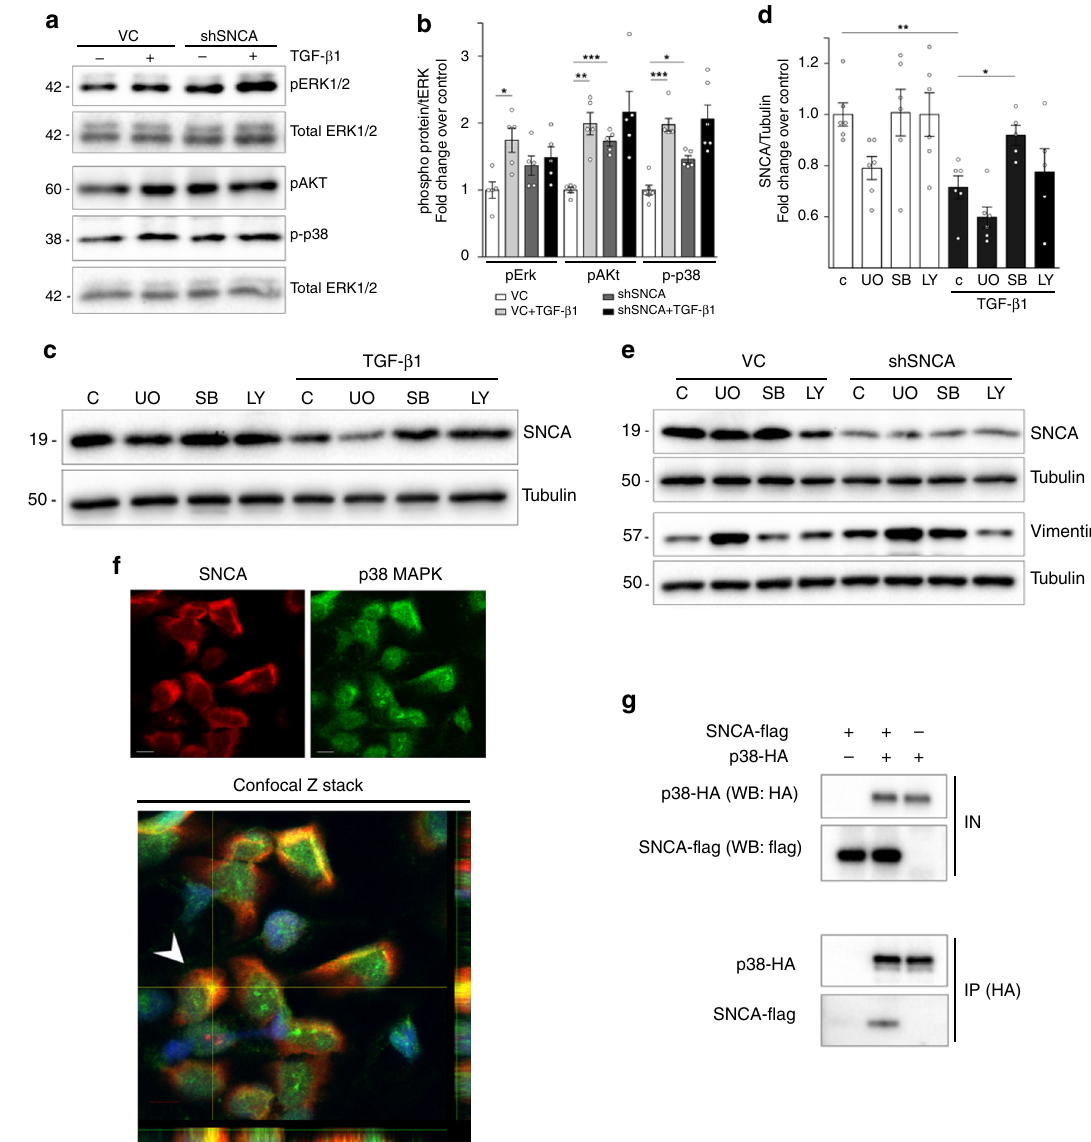
Fig. 3 SNCA modulates the activation of ERK1/2, Akt and p38 in vitro. a , b HK-2 cells were incubated separately with either serum-free medium or 2 ng/ ml TGF- β 1 for 60 min. Cell lysates were immunoblotted with antibodies against pERK1/2, p-p38, pAkt, total ERK1/2, and tubulin. Representative Western blots ( a ) and quantitative densitometric analysis ( b ) show levels of phosphorylated ERK1/2, p38, and Akt in HK-2. Data were normalized to total ERK1/2 ( b ) and presented as mean ± SEM of at least n = 3 independent experiments. c – e Effect of MAPK inhibitors (U0126 and SB203580) and PI3K-Akt inhibitor (LY294002) on TGF- β 1-induced decrease in SNCA expression ( c , d ), as well as SNCA knockdown-induced increase of vimentin in HK-2 ( e ). HK-2 were pretreated for 1 h with UO126, (UO; 10 µ M/L), SB203580 (SB; 20 µ M/L) or LY294002 (LY; 10 µ M/L), after which cells were incubated either with serum- free medium or TGF- β 1 (2 ng/ml) for 72 h. Cell lysates were immunoblotted with antibodies against SNCA ( c , e ), vimentin ( e ) and tubulin. Representative Western blots ( c , e ) and quantitative densitometric analysis ( d ) show levels of SNCA ( c , e ) and vimentin ( e ) in HK-2. Data were normalized to tubulin ( d ) and presented as mean ± SEM of at least n = 3 independent experiments. f The confocal Z stack shows colocalization of p38 with SNCA in the cytoplasm of HK-2. HK-2 cells were grown under normal conditions and were stained using anti-SNCA (red) and anti-p38 antibody (green). Nuclei were labeled by Hoechst (blue). The lower and right panels in the confocal Z stack show a vertical cross section (yellow lines) through the cells. Arrow, SNCA colocalized with p38 MAPK in the cytoplasm. Scale bar represents 10 µ m. g Immunoprecipitation of SNCA with p38. HEK293T cells were co-transfected with p38-HA and SNCA- fl ag. After crosslinking with DSP, p38 was immunoprecipitated from the cell lysates using antibodies against HA, as explained in Supplementary Methods. Lysates and immunoprecipitates were probed on Western blots with antibodies against fl ag and HA. * p < 0.05, ** p < 0.01, *** p < 0.001. The p -value by two-way ANOVA. C — control. Source data are provided as a Source Data fi